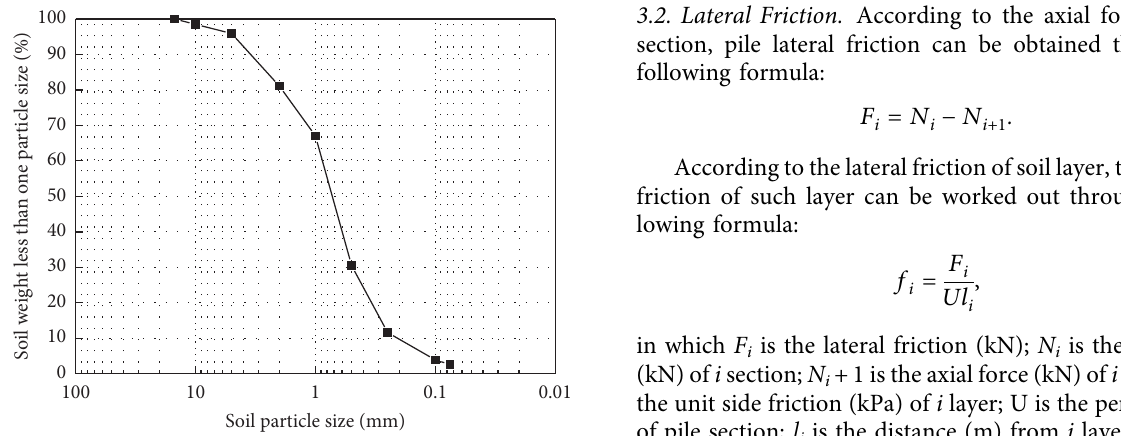
Figure 4: The grain composition of sand